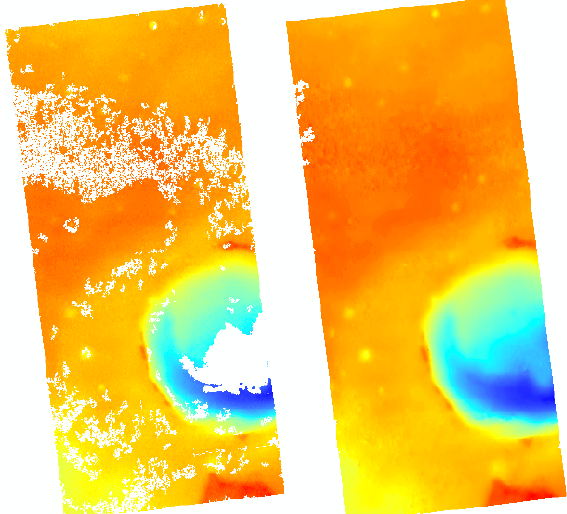
Figure 5. An example of MER-B DTM after bad matching rejection in CASP-GO (left) and final DTM using Gotcha densification and